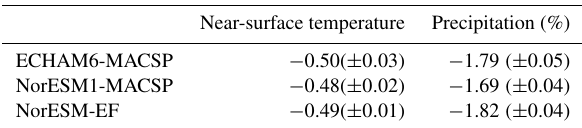
Table 2. Summary of modern-day global-mean change of tempera- ture and precipitation. Standard errors of means are shown in brack-